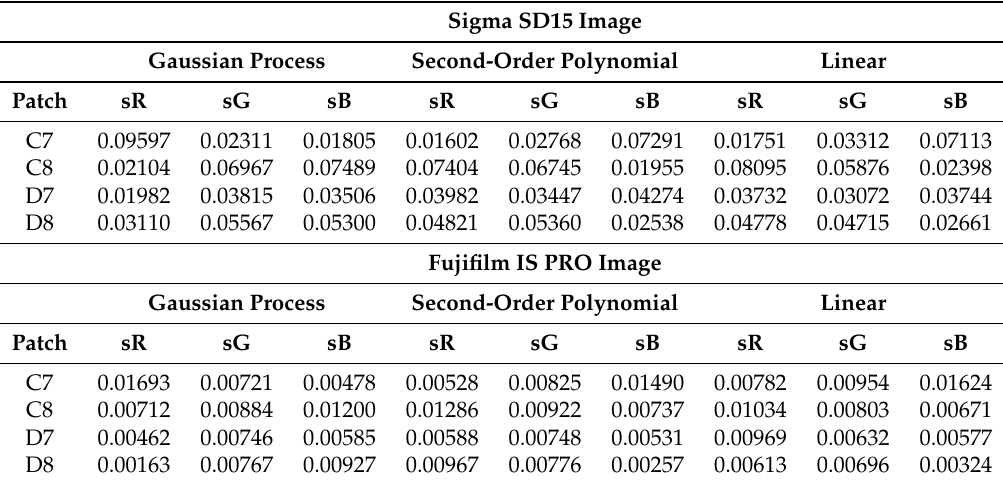
Table 6. Variation coefficients of the output sRGB digital numbers.